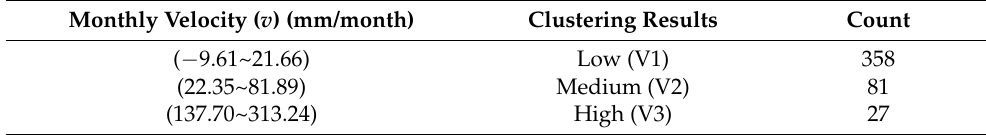
Table 4. Clustering results of the monthly velocity (ZG93, ZG118, XD01). Monthly Velocity ( v )